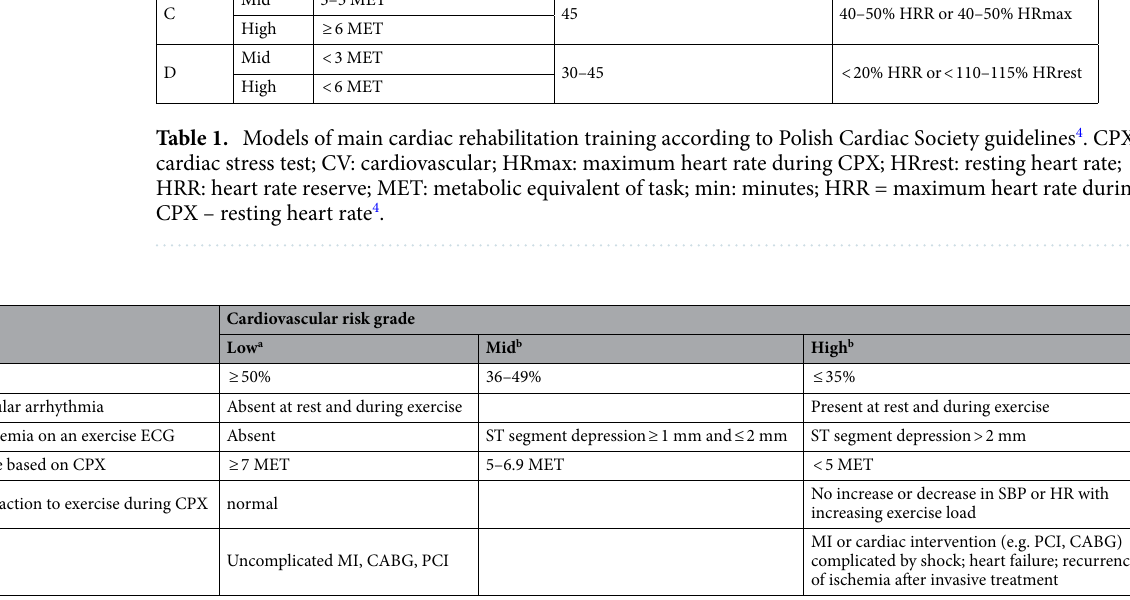
Table 2. Patient’s cardiovascular risk grade stratification according to Polish Cardiac Society guidelines 4 . CABG: coronary artery bypass grafting; CPX: cardiac stress test; ECG: electrocardiogram; HR: heart rate; LVEF: left ventricular ejection fraction (the most current data based on medical documentation was used); MET: metabolic equivalent of task; MI: myocardial infarction; PCI: percutaneous coronary intervention; SBP: systolic blood pressure. a All criteria present; b at least one criterion